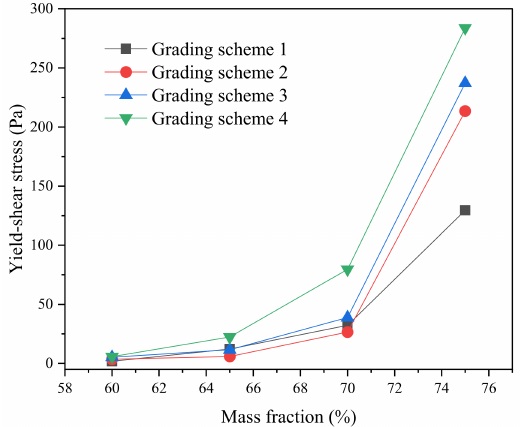
Figure 5. Effect of mass fraction on yield shear stress.